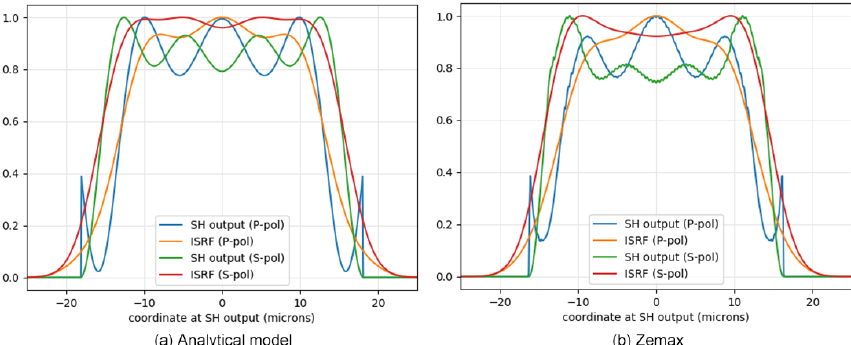
Figure 10. SH output illumination and resulting ISRF in P and S polarization for a SH length of 1mm, F number = 4.5, and λ = 1600nm. (a) Analytical model, (b) Zemax. A square pupil and an interference model were